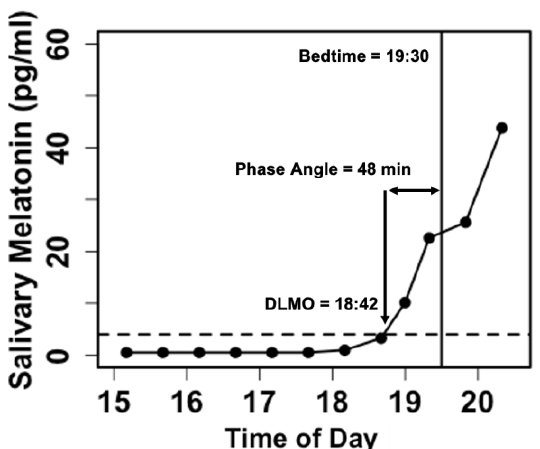
Figure 4. Example of a dim light melatonin curve for one individual child participant. Each black dot represents a saliva sample collected. The dotted line denotes the DLMO threshold of 4 pg/ml. In this example, the child’s scheduled bedtime (lights-out time) was 19:30. DLMO was calculated as 18:42. The phase angle difference between lights-out time and DLMO was 48 min.